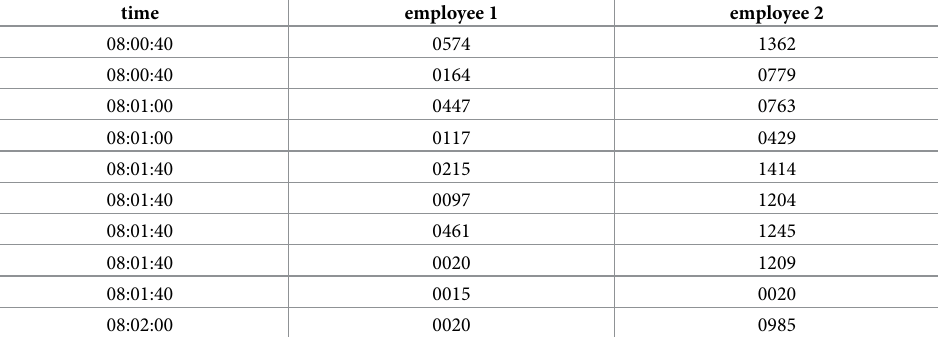
Table 1. The first 10 events from a relational event history with face-to-face contacts between employees in the